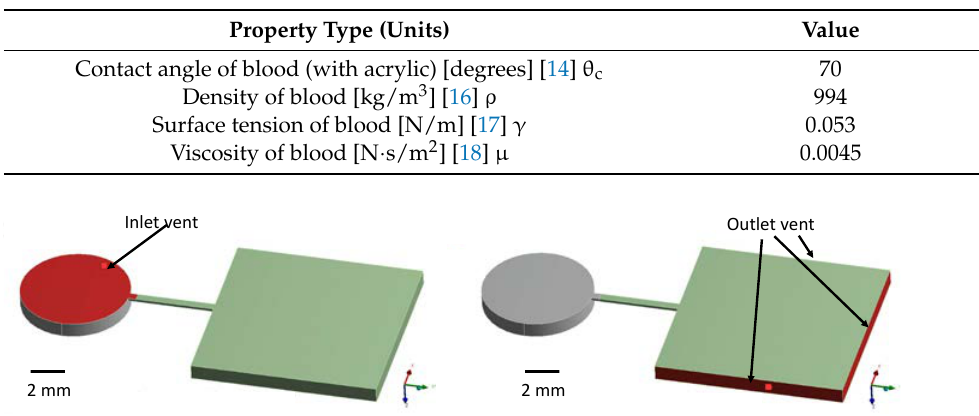
Figure 7. The Fluent FEA simulation was performed with the boundary conditions of the atmospheric pressure at the inlet vent for the whole blood sample ( left ) and the outlet vents along the side walls of the RBC chamber ( right ).